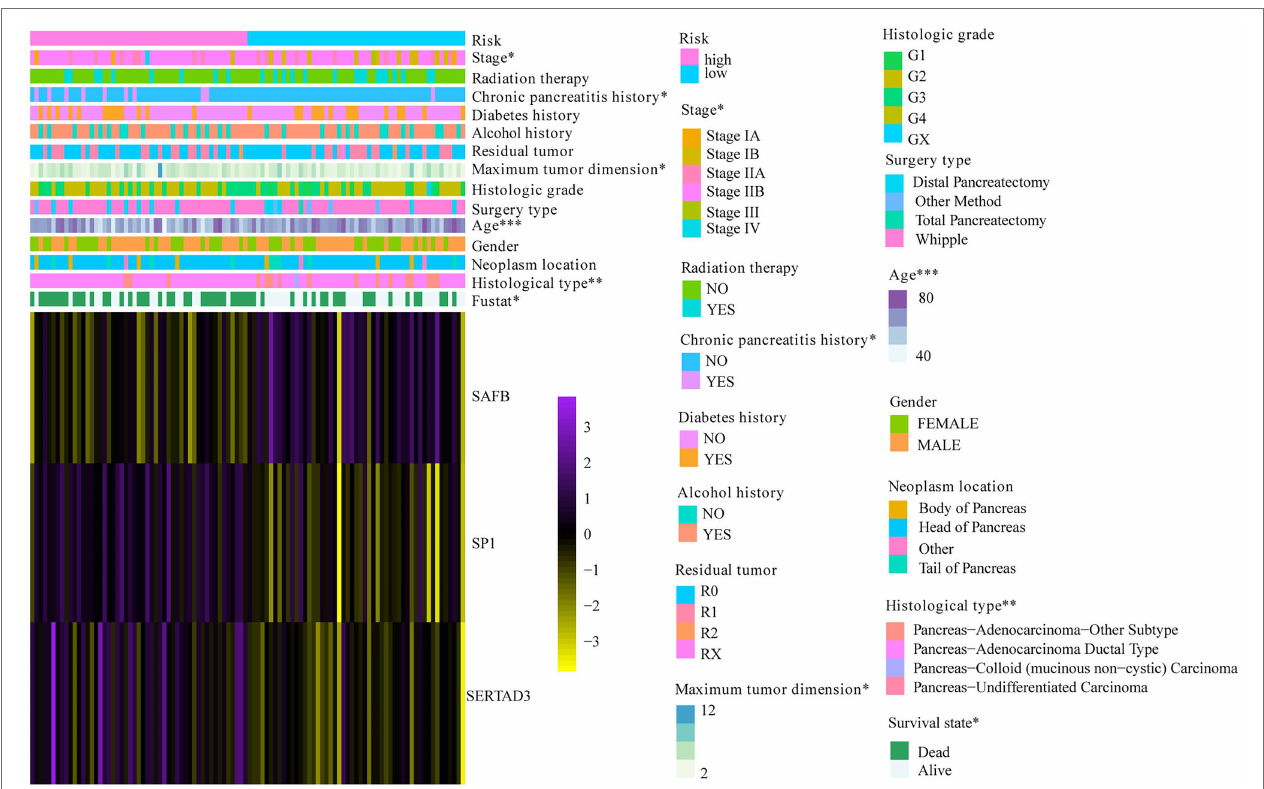
FIGURE 7 | The correlation between risk score and PAAD clinical characteristics. * p < 0.05; ** p < 0.01; and *** p <